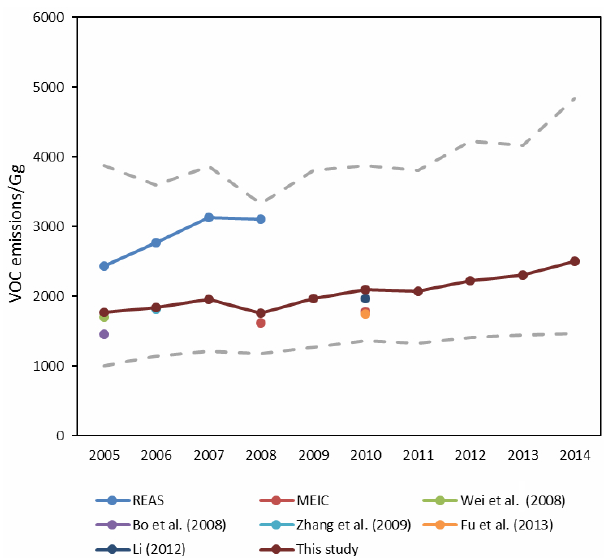
Figure 4. The interannual trends in anthropogenic NMVOC emis- sions in Jiangsu from 2005 to 2014. The grey dotted lines indicate the 95% CIs of emissions estimated in this study. The results from other inventories are illustrated as well for